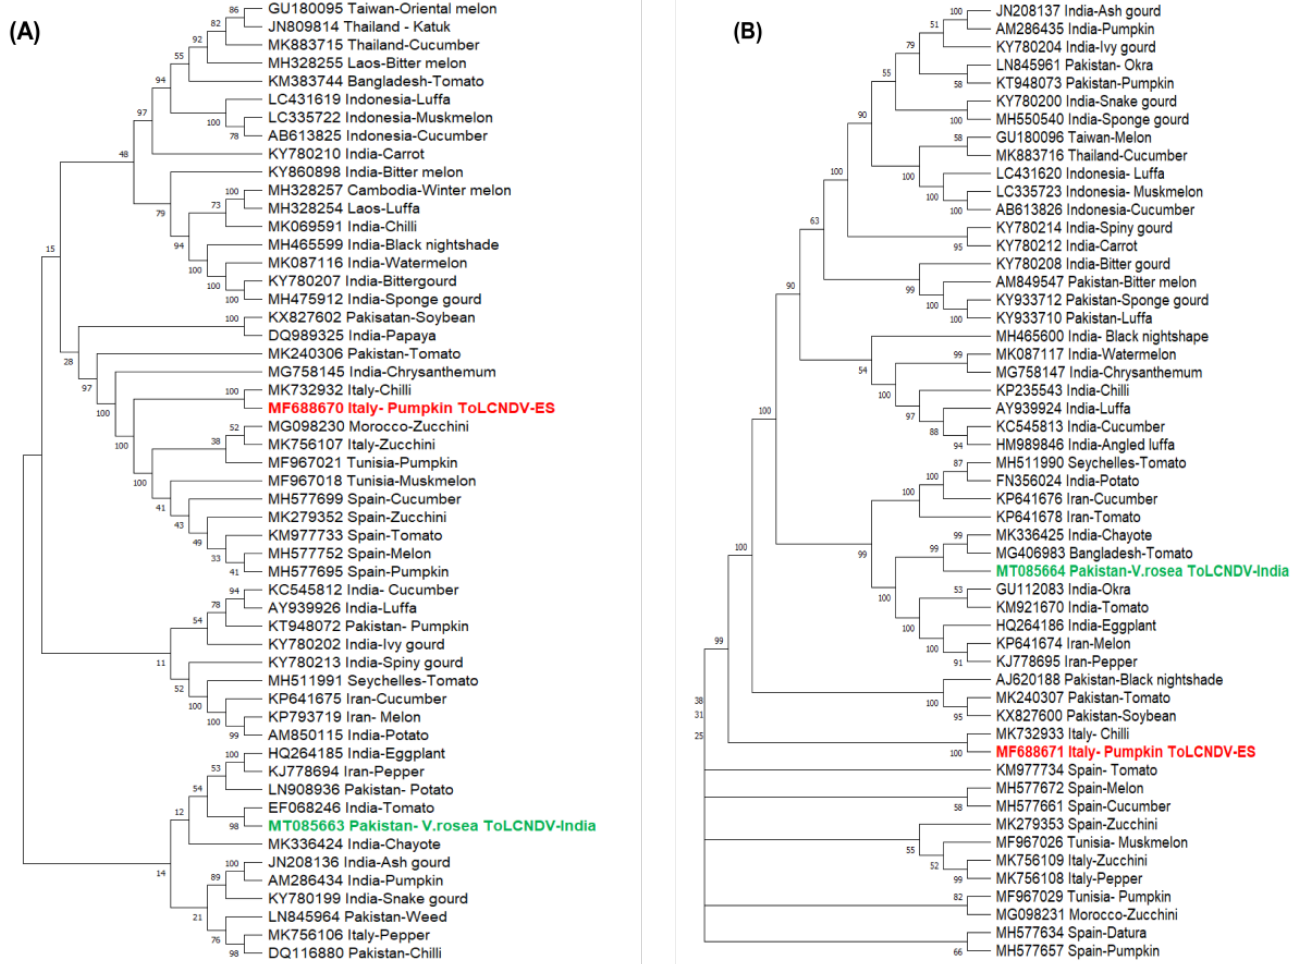
Figure 1. Phylogenetic analysis of two ToLCNDV isolates from Italy (ToLCNDV-ES) and Pakistan (ToLCNDV-India). Phylogenetic relationships were generated using the neighbor-joining methods in the MEGA 7 program. Numbers at branch internodes represent bootstrap values (1000 replicates). The ToLCNDV isolates from Italy (Accession number MF688670/MF688671) and Pakistan (Accession number: MT085663/MT085664) used in this study are highlighted by red and green colors, respectively. ( A ) DNA A component. ( B ) DNA B component.